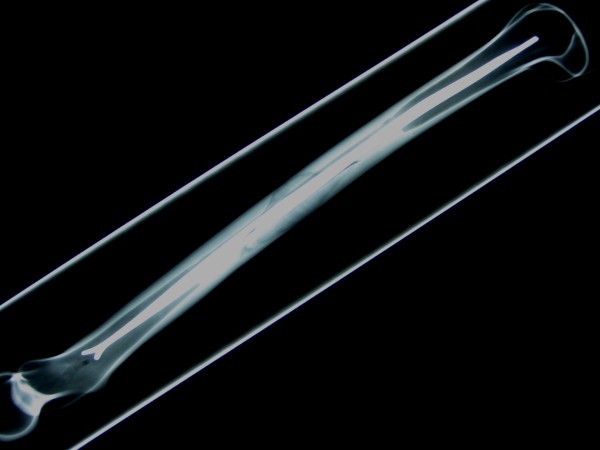
Lateral Fluoroscopic image of a Sawbone®composite graft with a long spiral fracture after implantation of two elastic stable intramedullary nails; the endings of the nails (2 C-configuration) are inferior to the greater Trochanter.